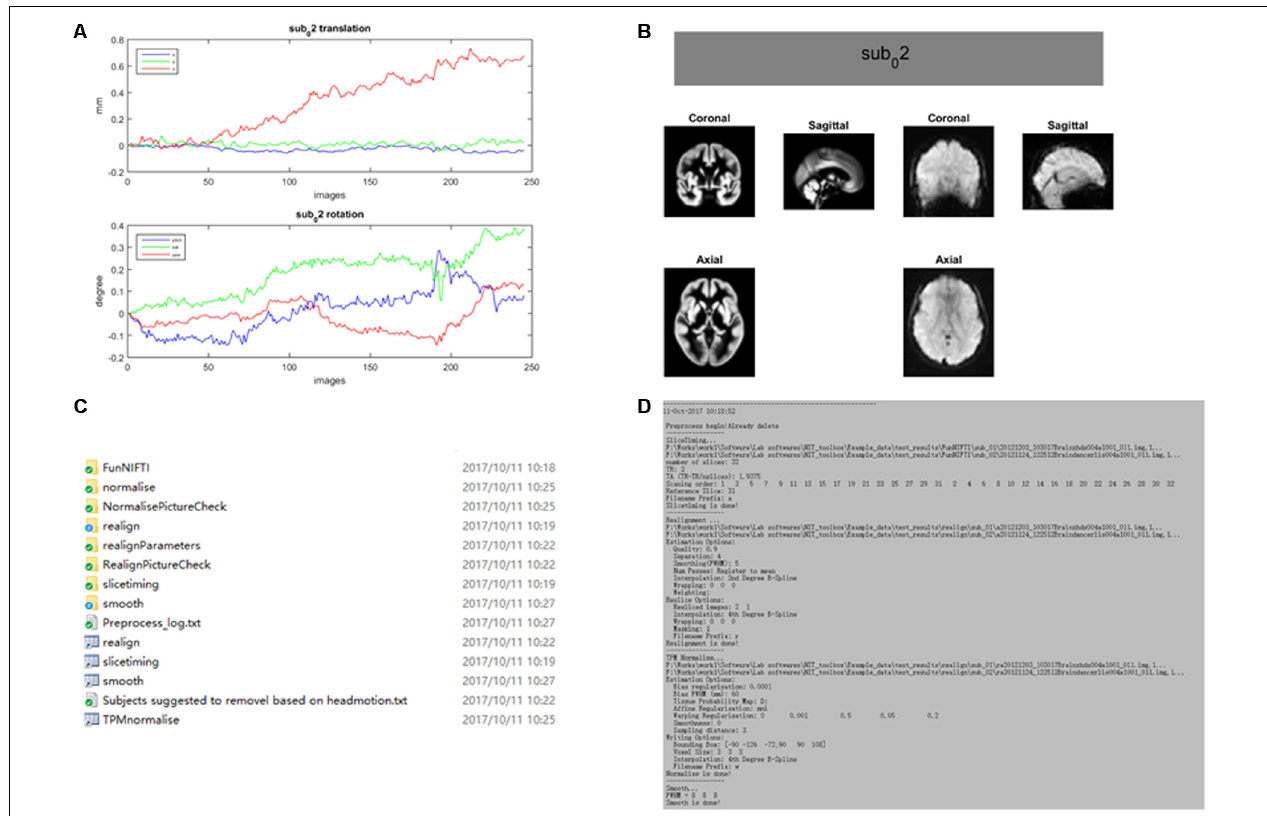
FIGURE 4 | An example of fMRI preprocessing outputs using the NIT. All of the outputs in the NIT will be well organized and saved into separate folders. (A) Figure of head motion parameters; (B) TPM template and normalized image (first volume); (C) output folders; and (D) preprocessing